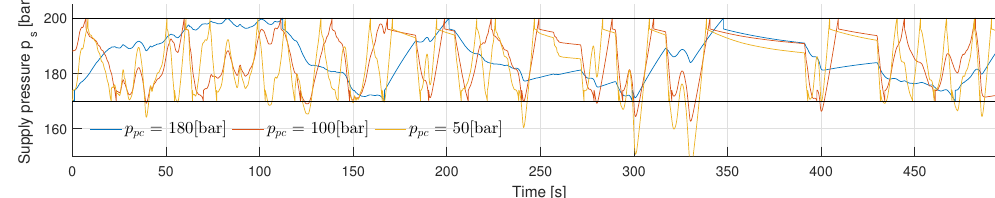
Figure 6. Simulated supply pressure signal p s , for three levels of pre-charge pressure in the nominal operating